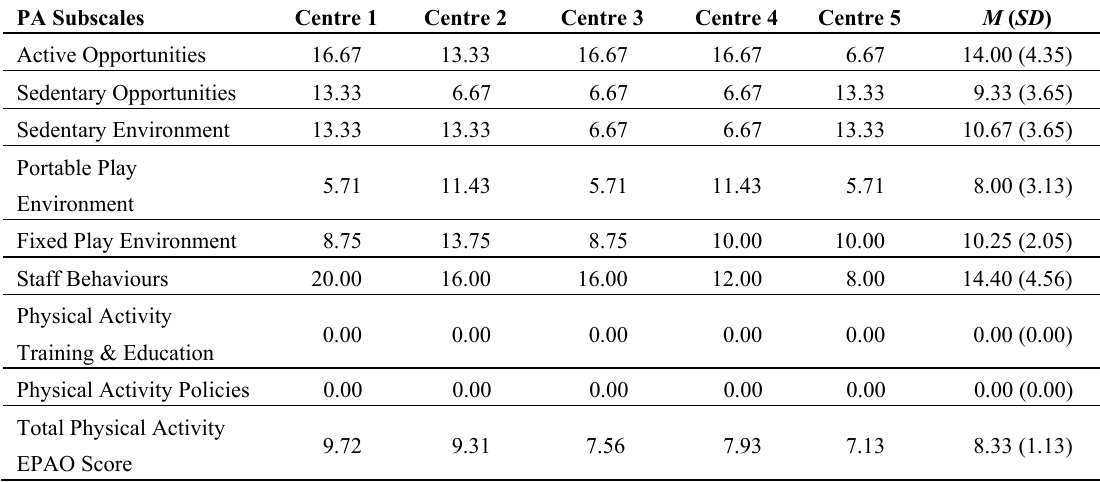
Table 1. Physical Activity Subscale Scores and Total Physical Activity EPAO Score for Participating Childcare